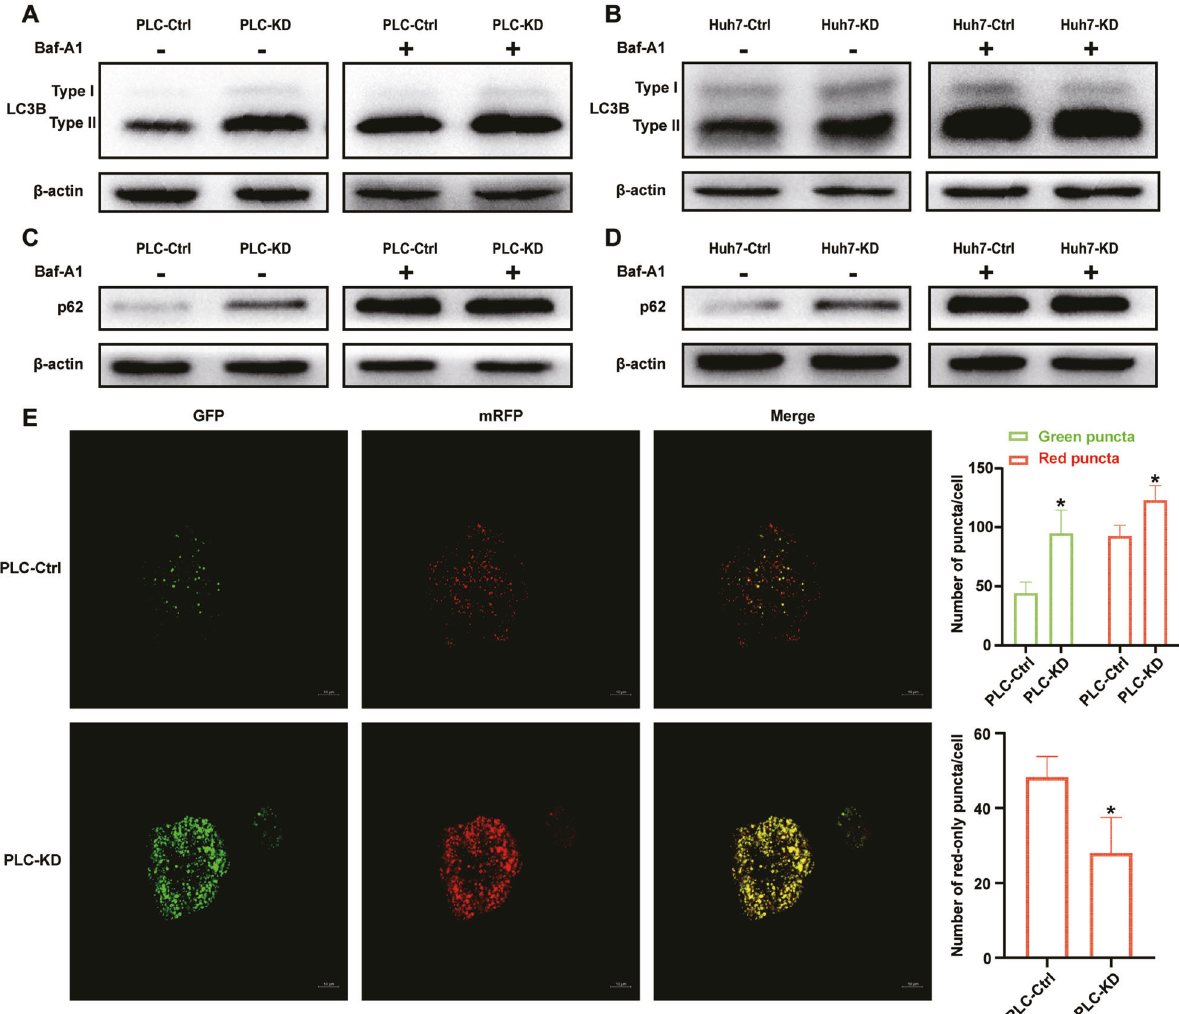
Fig. 5 Knocking down DNAJC24 disrupts autophagic fl ow. A , B , C , D DNAJC24-KD cells and control cells were cultured under normal conditions or in medium supplemented with Ba fi lomycin A1 ( fi nal concentration 400 nM) for 24h. Western blotting was performed to determine protein levels of LC3B ( A , B ) and p62 ( C , D ) in cell lysates. C PLC DNAJC24-KD cells and control cells transfected with GFP-mRFP-LC3 lentivirus and analyzed by confocal microscopy. Quanti fi cation of the number of fl uorescent puncta exhibiting green (GFP), red (mRFP) or red- only fl uorescence (obtained by subtracting green puncta to the total red puncta) is shown (right graphs). Pictures at higher magni fi cation are shown. Bars, 10 μ m. Data were presented as mean ± SEM. n = 3. * P < 0.05.